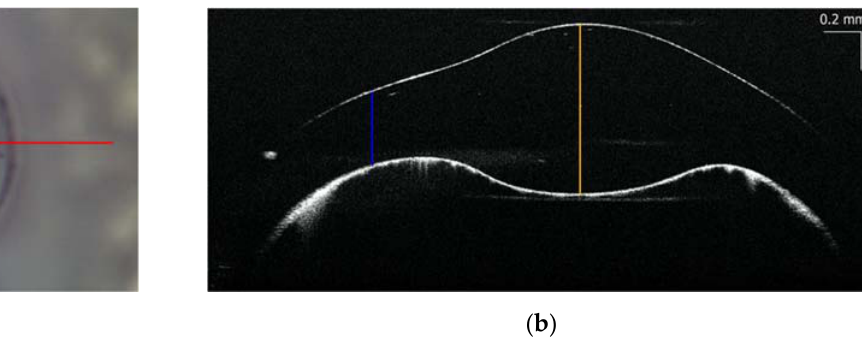
Figure 3. Bottom of the glass vials (upside down): ( a ) visible image—10 mm long red arrow denotes the position of the OCT measurement in b; ( b ) cross-sectional OCT image—the yellow and blue lines indicate the thickness of glass to be, respectively, 0.9 mm and 0.4 mm.